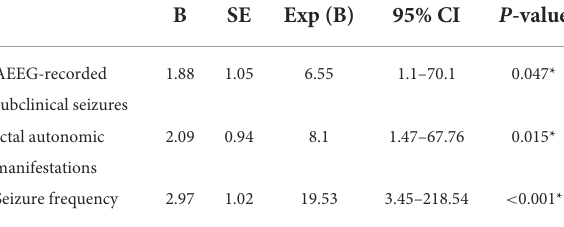
TABLE 2 Firth’s multivariate logistic regression